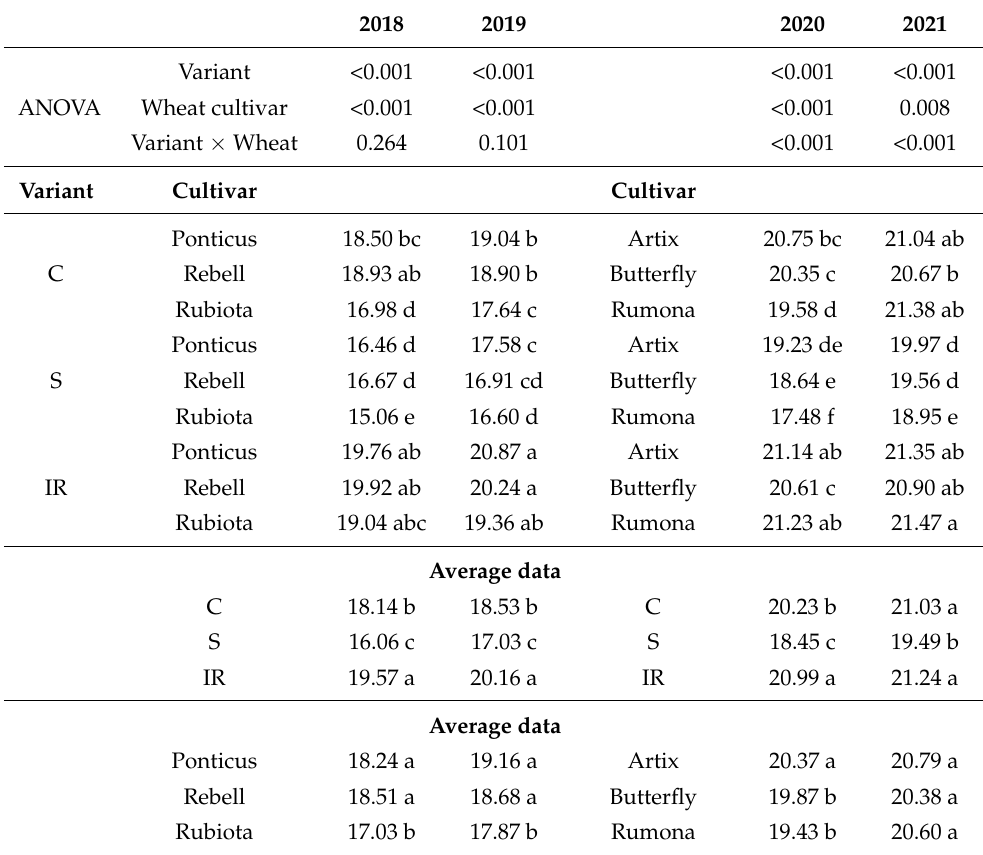
Table 6. Results of analysis of variance of 13 C discrimination in grain of three wheat